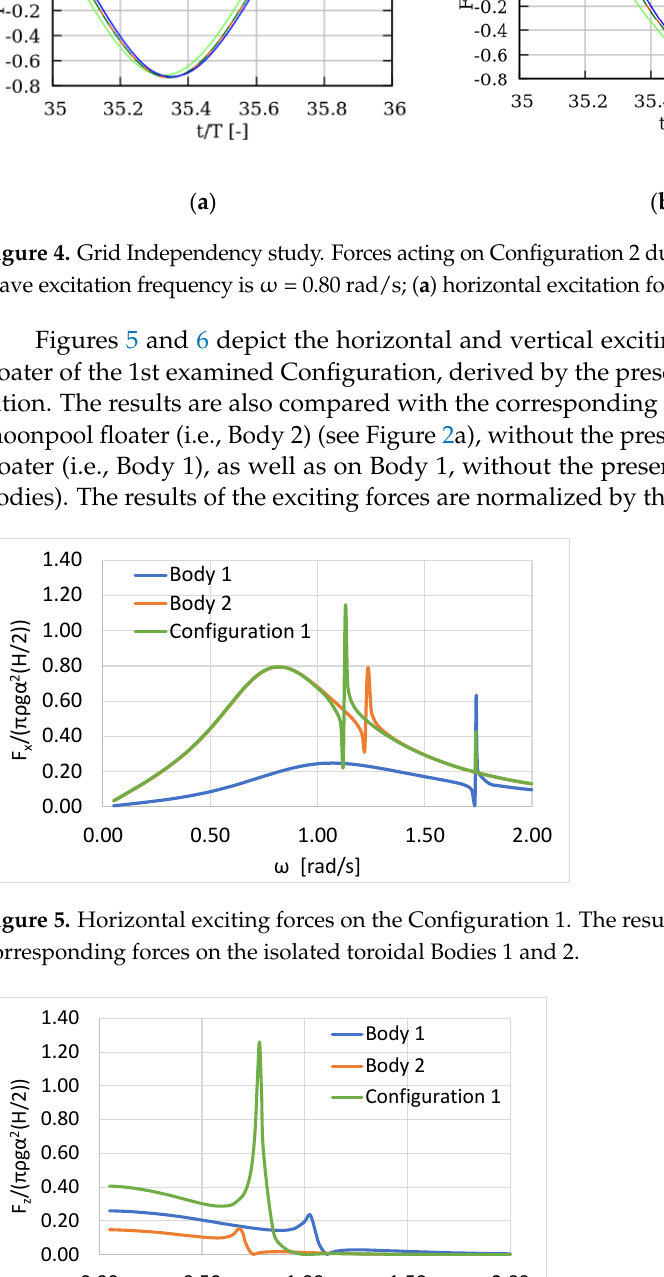
Figure 6. Vertical exciting forces on the Configuration 1. The results are also compared with the corresponding forces on the isolated toroidal Bodies 1 and 2 .